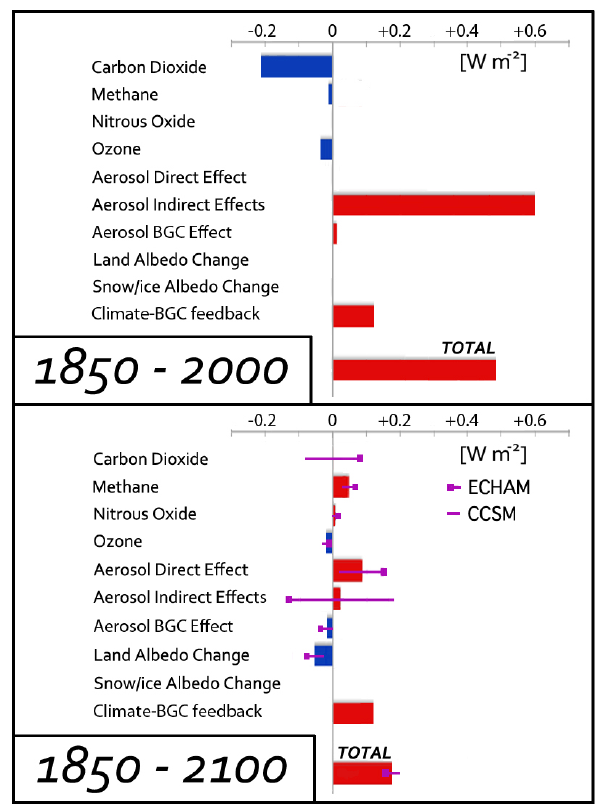
Fig. 12. Global, annual average RF for the various impacts of fire examined in this study relative to the pre-industrial forcings (Fig. 11) for present day fires (1850-2000) and for year 2100 fires (1850-2100). For 1850-2100, the average RF for the two sets of fire emissions used in 2100 (CCSM and ECHAM atmospheric forcing) is given with the range shown as the purple lines.